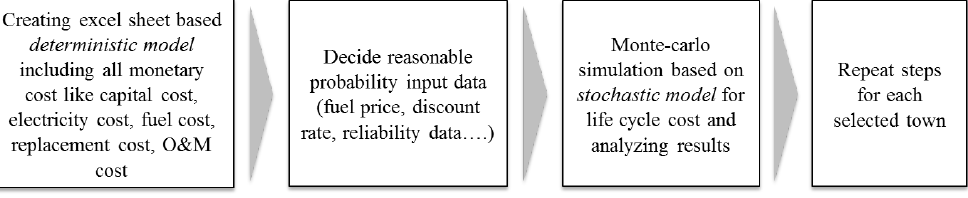
Figure 1. Procedure of cost analysis. O&M: operating and maintenance.